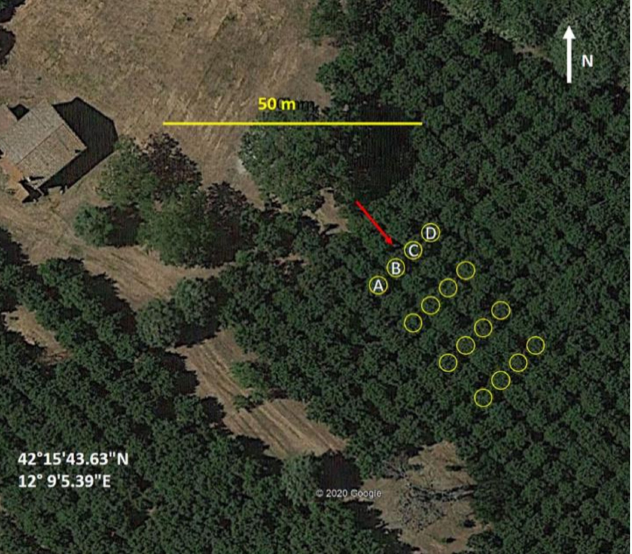
Figure 1. Location and scheme of the experimental test. The red arrow indicates the path of the sprayer (photo from Google Earth).